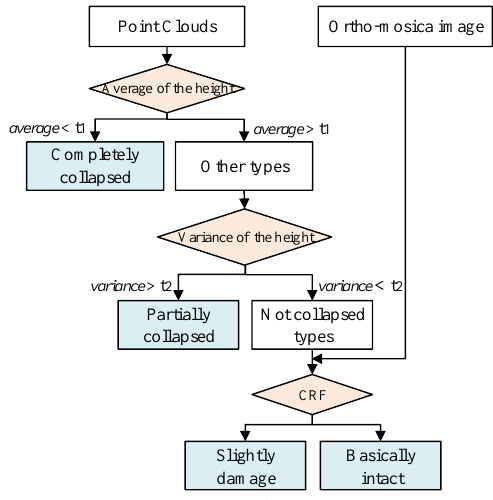
Figure 3. Interpretation rule for building damage types